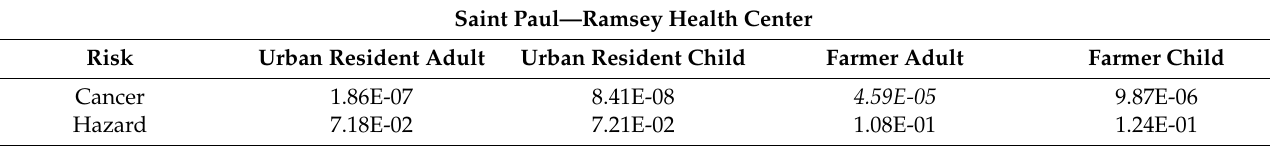
Table 12. Total Individual Benzo(a)pyrene Cancer Risks and Noncancer Hazards. Saint Paul—Ramsey Health